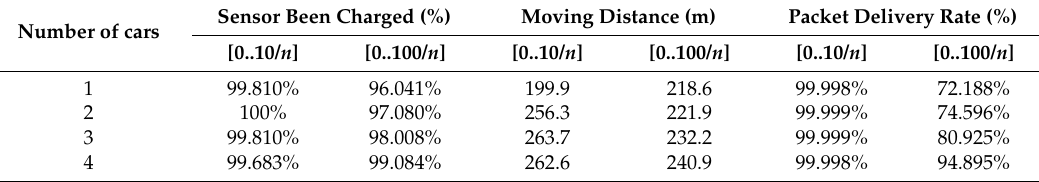
Table 4. Simulation results with varying numbers of